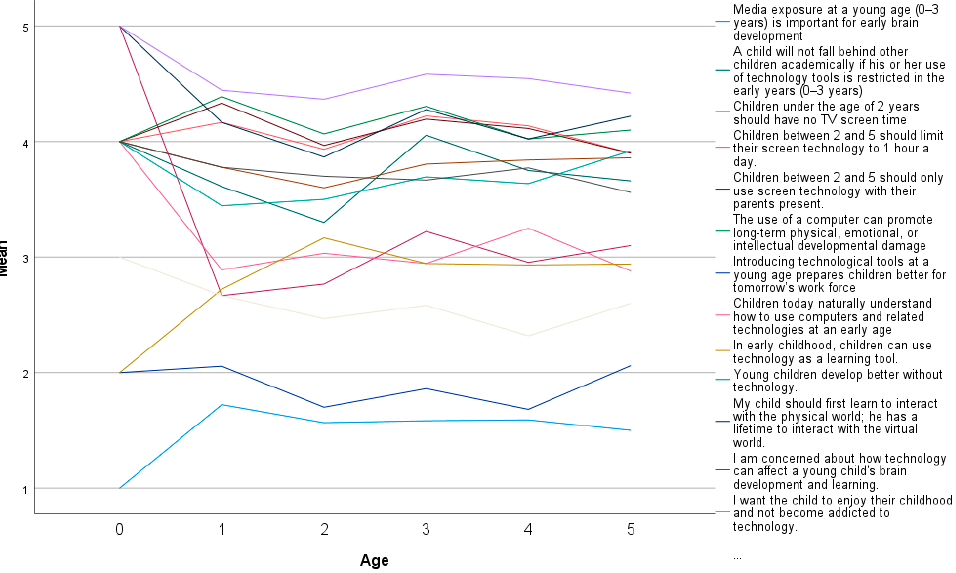
Figure 1. Parents’ attitudes towards digital technology in child’s development and learning.